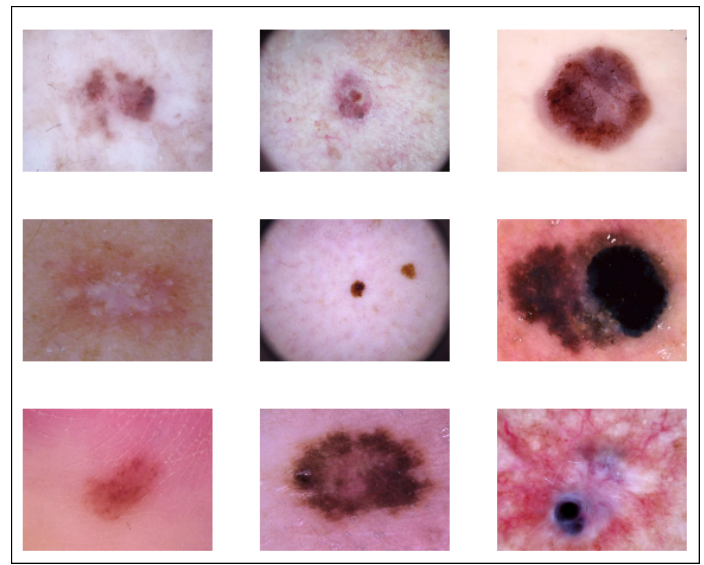
Figure 2. Augmented